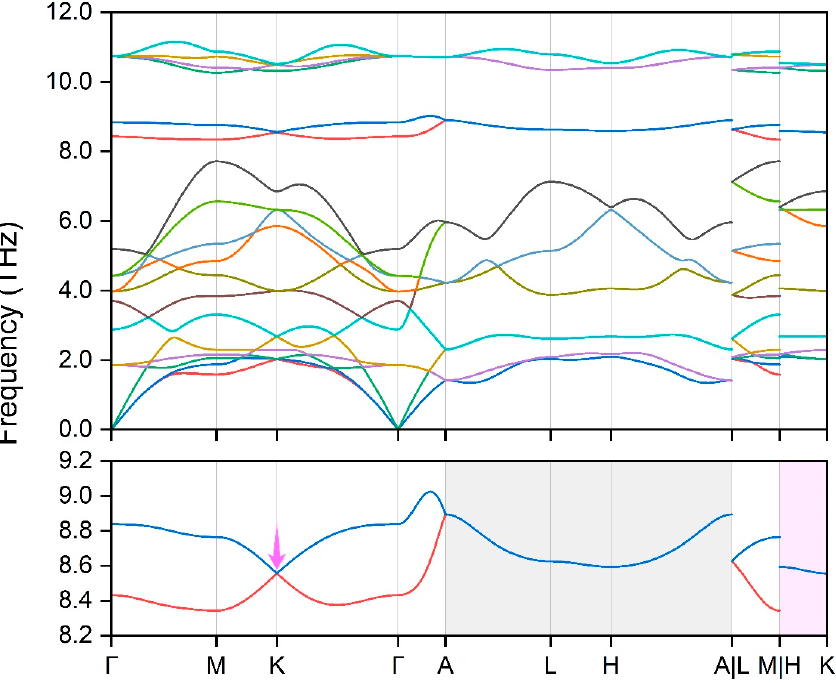
Figure 2. The calculated phononic spectrum of the ternary phosphide compound BaLiP along high symmetry paths. The bottom panel corresponds to the local enlargement of the two band distributions at the frequency range from 8.2 to 9.2 THz. The color shaded areas along A-L-H-A and H-K highlight the doubly degenerate convergence between these two bands. The band crossing at K point is indicated by the arrow.